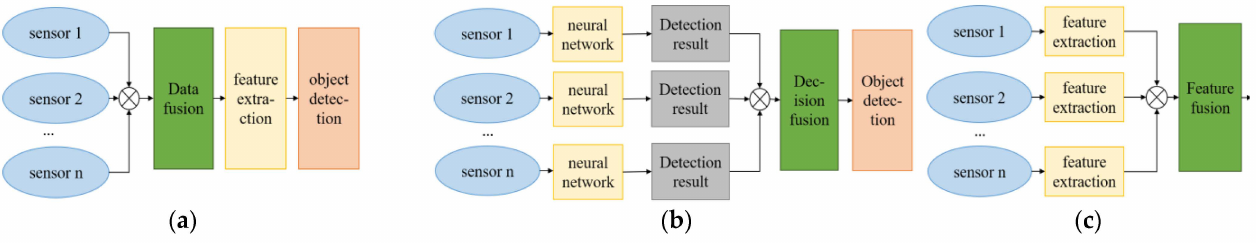
Figure 2. Fusion method of different information levels: ( a ) data-level fusion; ( b ) decision-level fusion; ( c ) feature-level